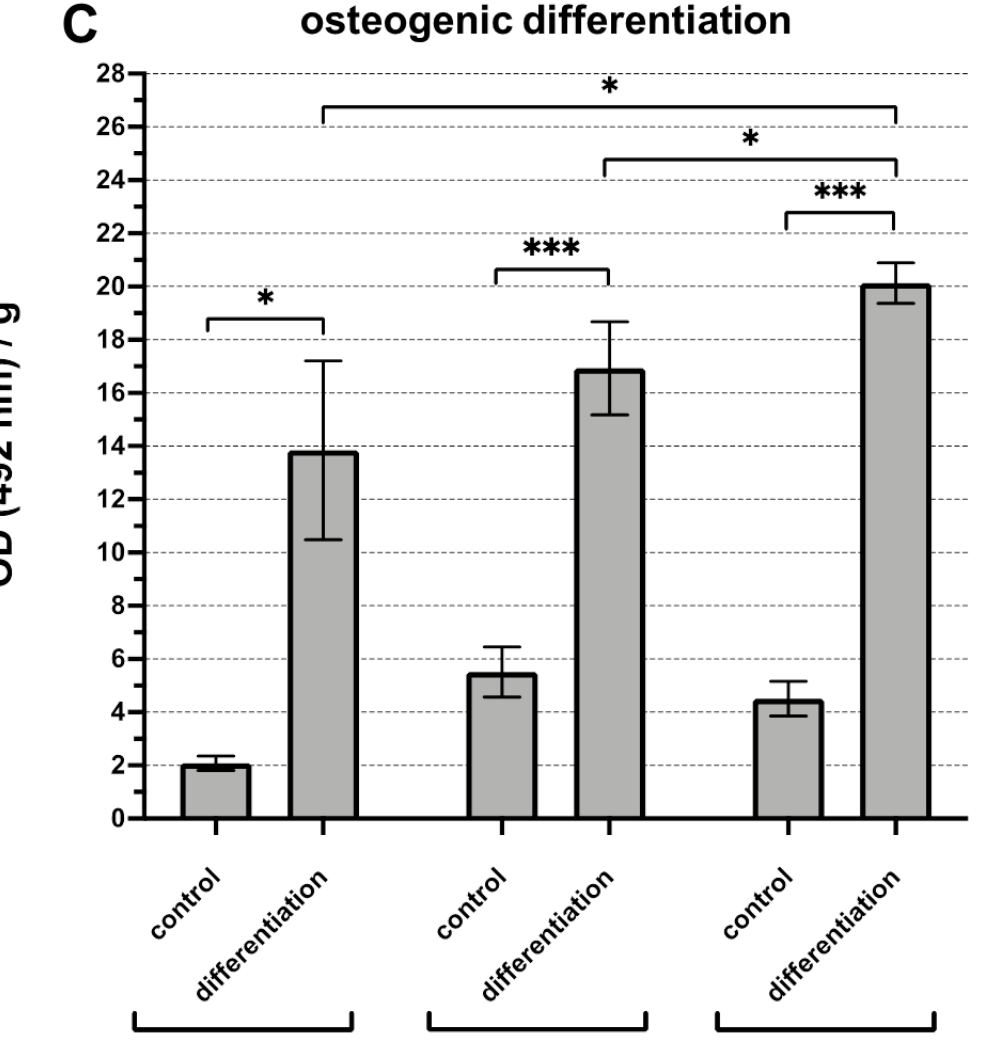
Figure 3. Chondrogenic, adipogenic and osteogenic differentiation of ASCs in GelNB/GelS-low, GelNB/GelS-medium and GelNB/GelS-high hydrogels. ASCs were dispersed in the hydrogels in triplicate and grown in normal growth medium (control) or the respective differentiation media for 21 days. ( A ) Chondrogenic differentiation was assessed via alcian blue staining. Shown are represenative images from ASCs grown in triplicate in each group (n = 3). Scale bars: 100 µm. ( B ) Adipogenic differentiation was assessed by oil red O staining and the quantification of lipid vesicle formation was performed via digital image analysis (n = 3). Values represent the average numbers of red-stained pixels per cell. Shown are means ± SD (n = 3). ( C ) Osteogenic differentiation was assessed via alizarin red staining and the quantification of mineralization was achieved via the extraction of alizarin red and photometric measurements. Shown are means ± SD (n = 3). Asterisks indicate statistically significant differences between the groups (* p < 0.05, ** p < 0.005, *** p < 0.0005).